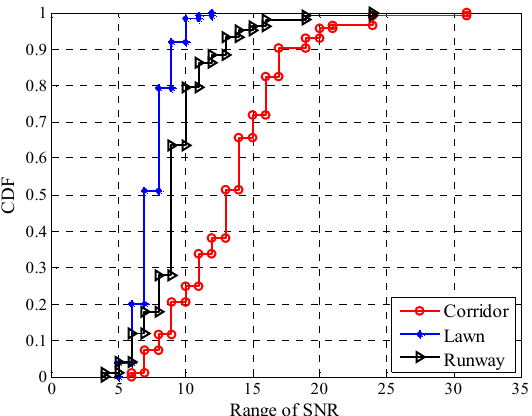
Figure 13. Cumulative distribution functions (CDFs) of the fluctuation range of SNR in different environments.